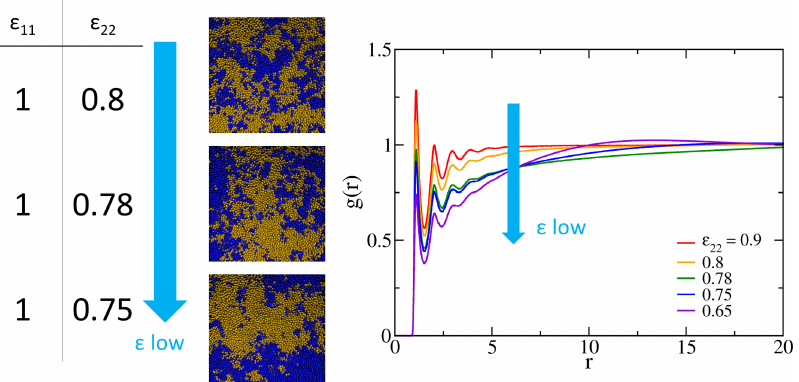
Figure 2. Left: simulation snapshots of binary blend systems at different values of the LJ potential well for the second polymer type. Chains of two colors denote two different polymer types. Right: the simulated radial distribution function between monomer beads for various ε 22 based on the one-fluid approximation